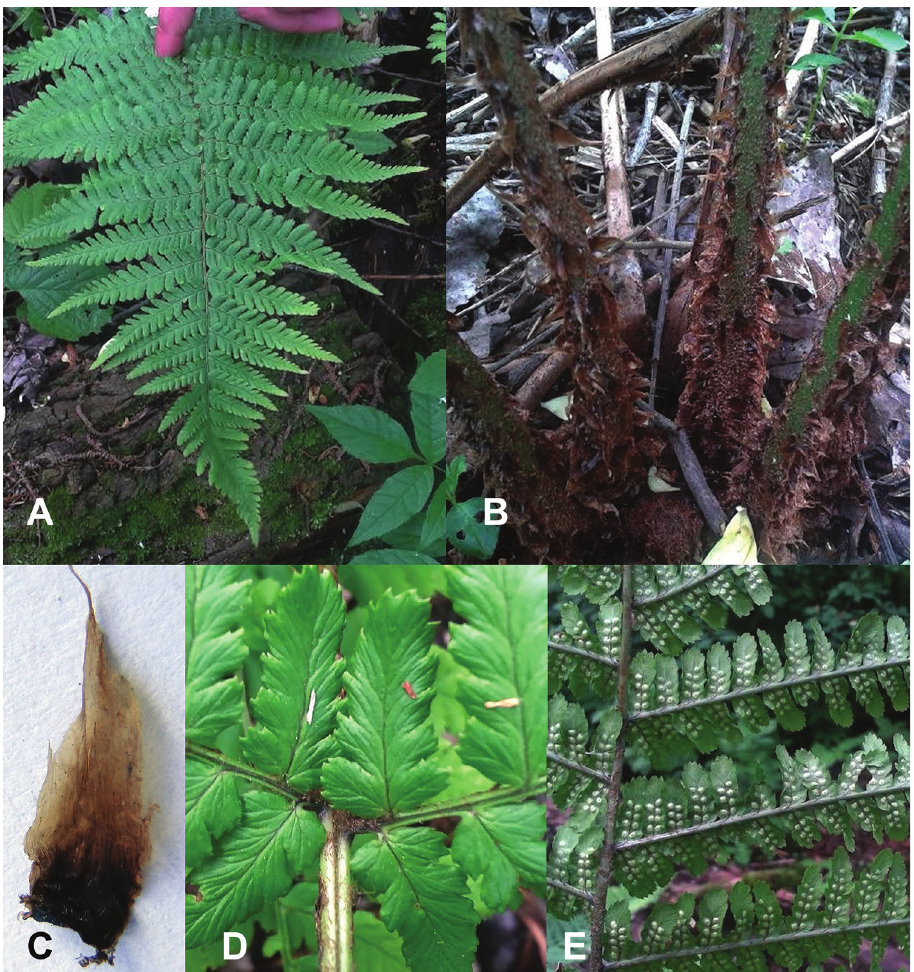
Figure 1. Dryopteris blanfordii subsp. nigrosquamosa morphology. A Frond of mature plants B Petiole covered with scales C Petiole scale D Adaxial surface of rachis and costa E Abaxial surface of rachis and costa. Two closely related species, namely D. arguta and D. marginalis, are native to North America. Dryopteris marginalis is evergreen and has tawny or cinnamon-col- oured scales, lanceolate and coriaceous laminae, with sori mostly at margins of ulti- mate pinnules’ segments (Table 1). Dryopteris arguta is winter green, having grassy- green to yellow-green, ovate-lanceolate, herbaceous, glandular laminae; the basal basis- copic pinnule and basal acroscopic pinnule are ± equal; its pinnule margins are serrate with spreading, spinelike teeth; the sori are medial. Both North American species have longer stipes (1/4–1/3 length of leaf), 1-pinnate-pinnatifid to 2-pinnate-pinnatifid fronds (Montgomery and Wagner